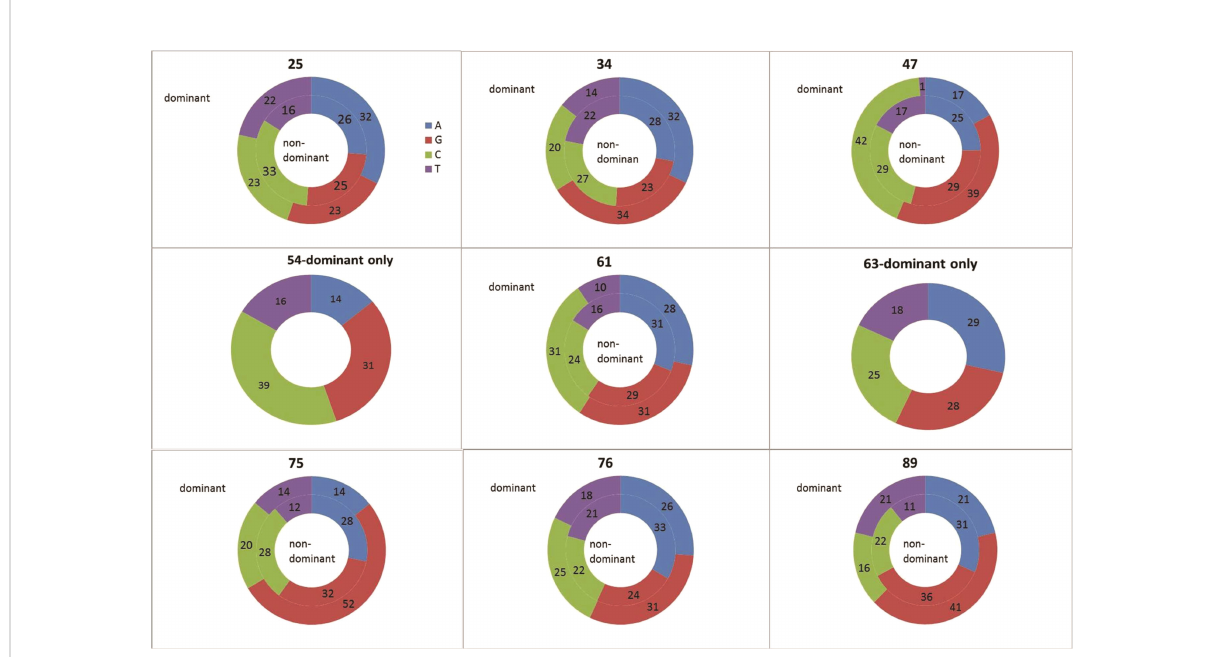
FIGURE 7 Single nucleotide mutation percentages in dominant and non-dominant clones. The mutation percentages in the dominant clones in each sample are plotted in the outer circles; the mutation percentages in non-dominant clones – in the inner circles. Mutations from Adenine are colored blue; Guanine – red; Cytosine – green; Thymidine –